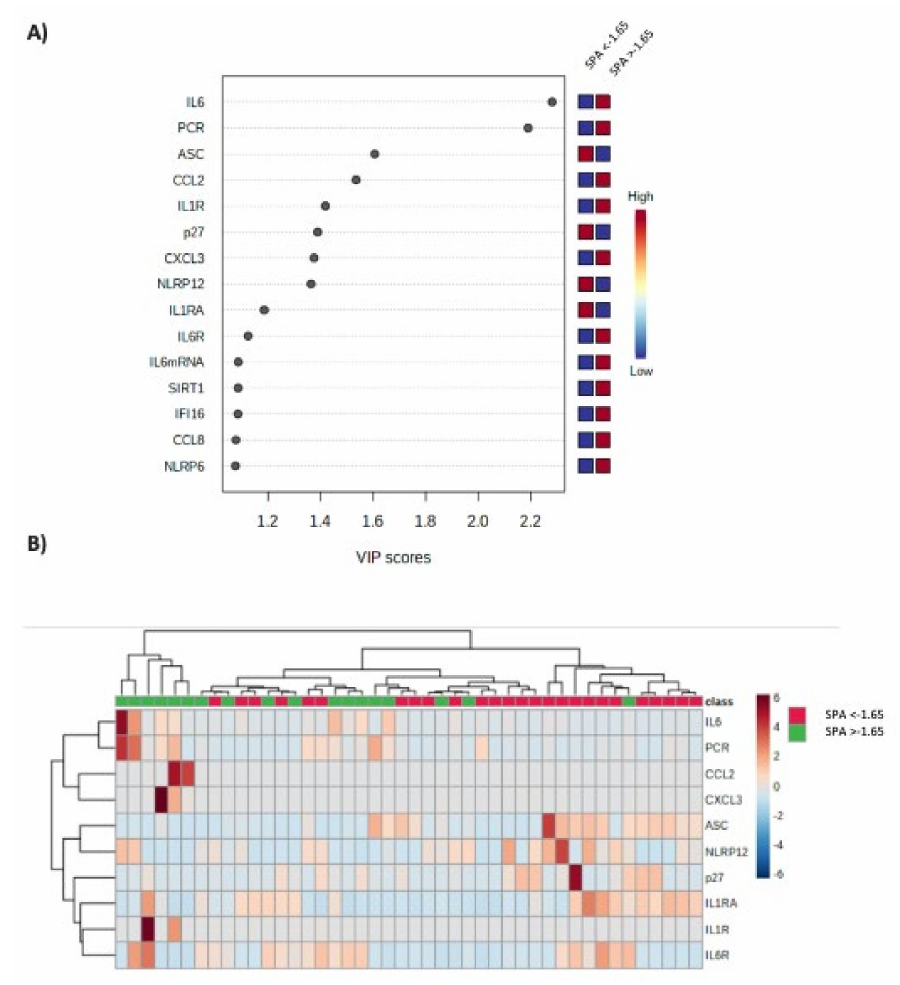
Figure 8. ( A ) VIP scores that summarize the contribution of the evaluated inflammasome compo- nents to discriminate patients with SPA < − 1.65. ( B ) Heatmap obtained with the expression levels of the components that better discriminate between patients with SPA < − 1.65 and > − 1.65 using bioinformatics analysis of